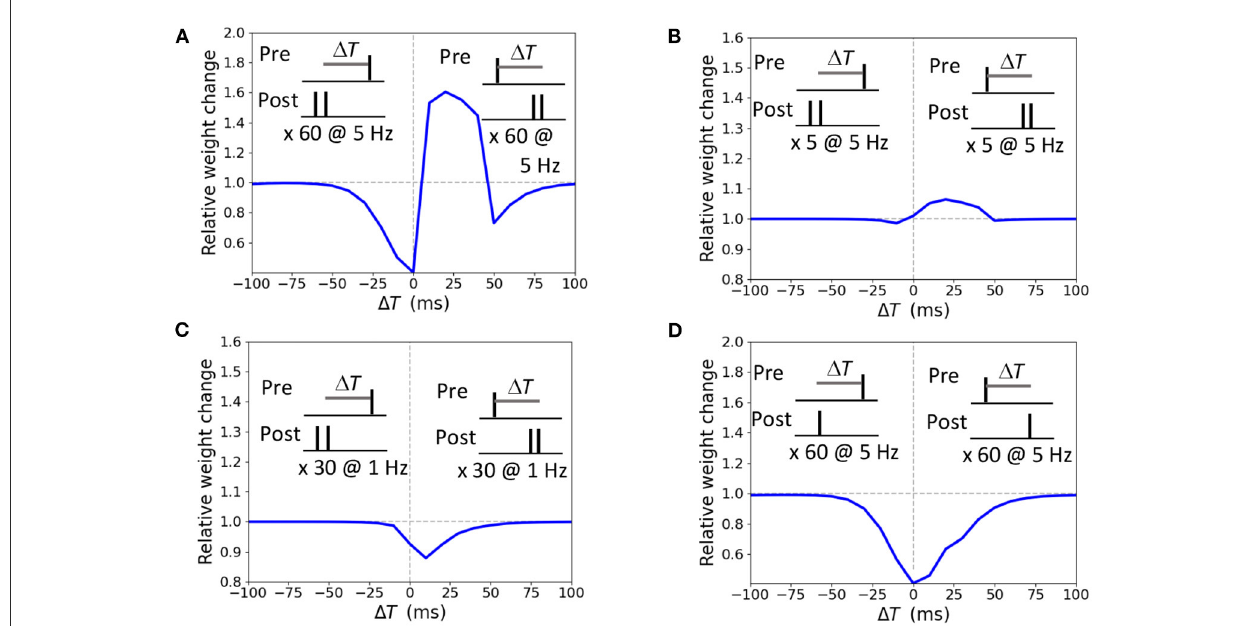
FIGURE3 Synaptic modifications induced by pairing a presynaptic action potential with a doublet (A–C) or a single postsynaptic action potential (D) . Temporal difference 1 T is measured between the presynaptic and a second postsynaptic action potential (A–C) or a single postsynaptic action potential (D) . (A) 60 pairings at 5 Hz lead to LTP and two LTD windows; (B) 5 pairings at 5 Hz induce LTP; (C) 30 pairings at 1 Hz triggers LTD; (D) 60 pairings at 5 Hz results in LTD.